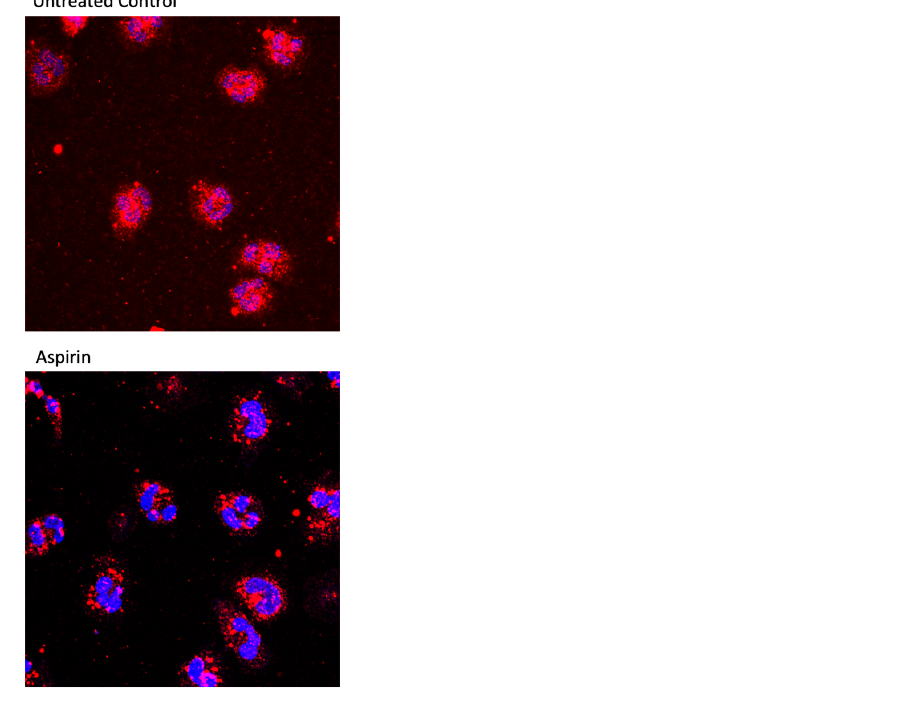
Figure 6. Percent nuclear localization of the p65 subunit of NF- κ B in preeclamptic pregnancy neu- trophils treated with aspirin or pinane TX. ( n = 5, * p < 0.05; ** p < 0.01; ASA, aspirin). Figure 7 shows the TXB2 media concentrations for neutrophils obtained from preeclamptic subjects. There was considerable variation among subjects, which appeared to be due to the use of aspirin. The lowest TXB2 concentration was for a subject who had mild preeclampsia. The next lowest value was from a subject on low-dose aspirin before